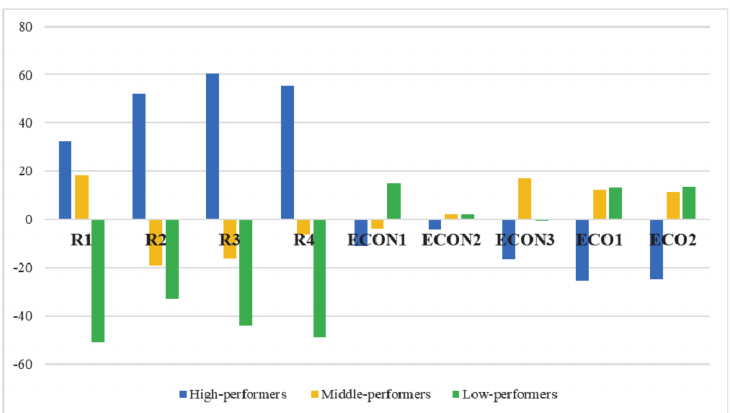
Figure 3. The differences regarding the observed indicators in comparison to the EU average across derived groups of countries in 2018.